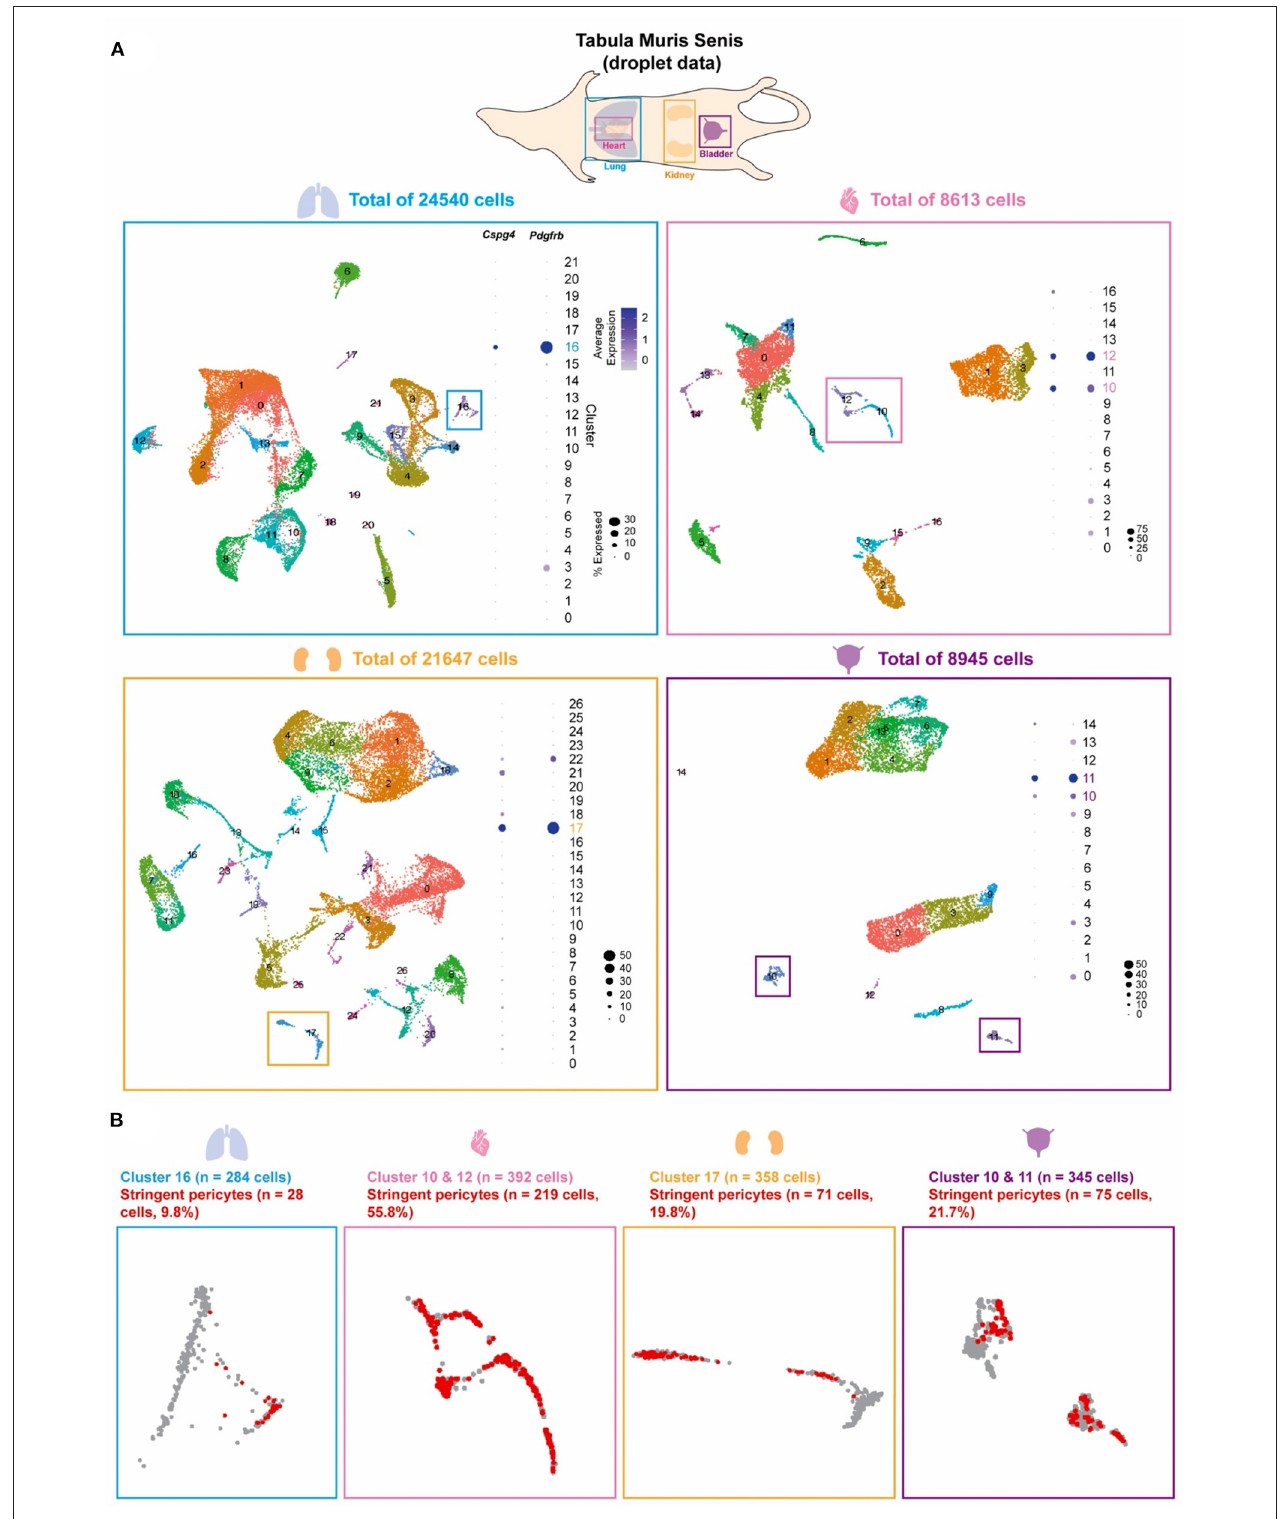
FIGURE 1 | Pericyte clusters are identified from mouse lung, heart, kidney, and bladder. (A) The Tabula Muris Senis dataset of the lung, heart, kidney, and bladder were used to identify pericytes within the cell population of each tissue. Graph-based unsupervised clustering identified 22, 17, 27, and 15 clusters for the lung, heart, kidney, and bladder tissue, respectively. (B) Pericyte-enriched clusters for each tissue were identified based on the expression of previously accepted pericyte markers Cspg4 and Pdgfrb . Cells that co-expressed Cspg4 and Pdgfrb within the identified pericyte-enriched clusters were stringent pericytes (shown in red).